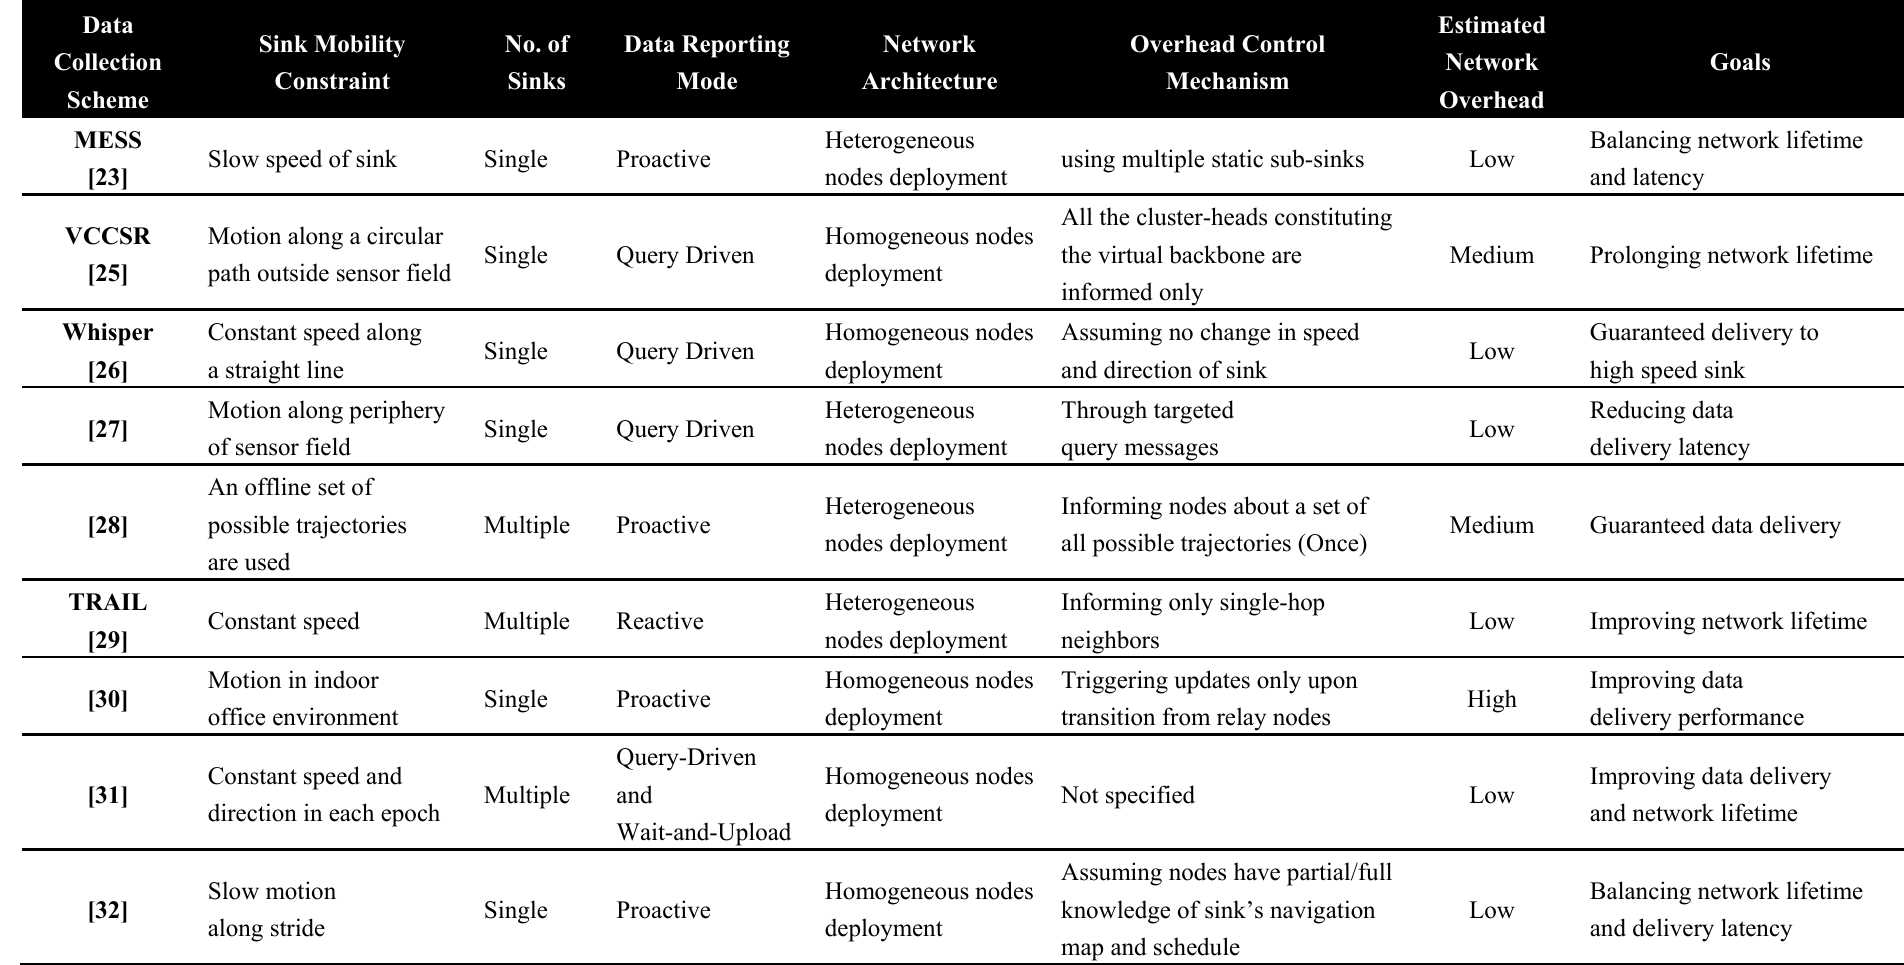
Table 1. Summary of path constrained based data collection